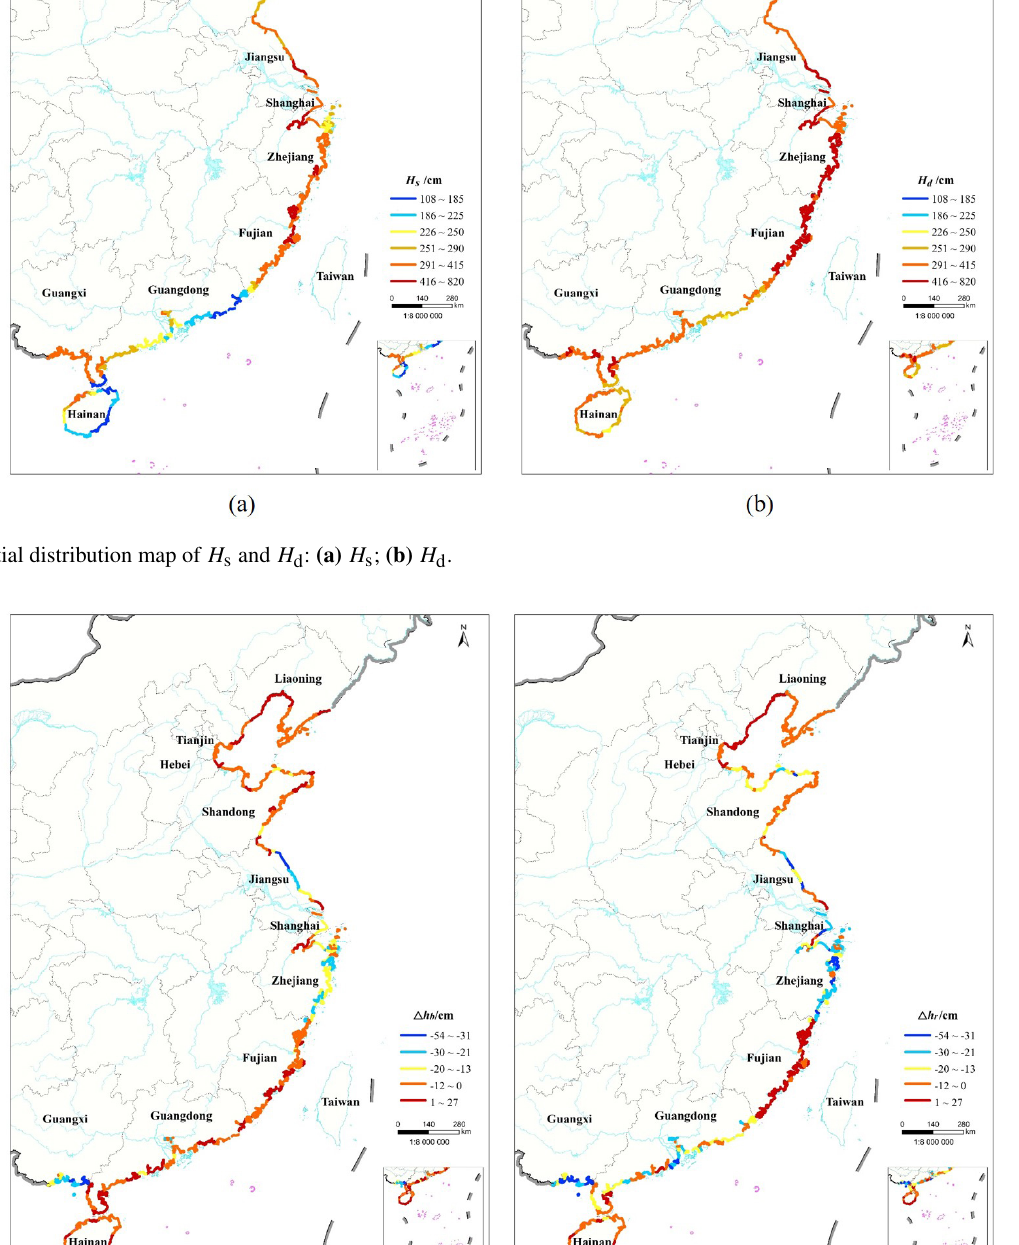
https://doi.org/10.5194/nhess-23-127-2023 Nat. Hazards Earth Syst. Sci., 23, 127–138,